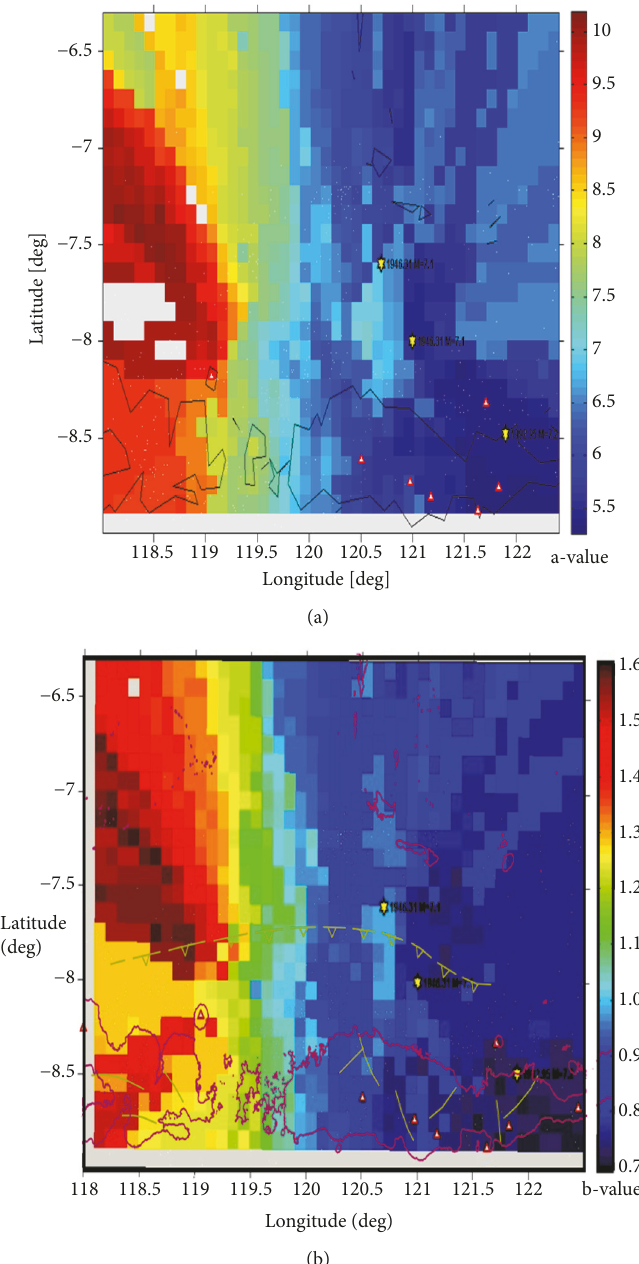
Figure 10: Spatial variation of seismicity of cluster 1 (Flores island, Labuan Bajo, and surrounding areas): (a) a-value and (b) b-value. 1996 and 2004. This is indicates the existence of a high level of stress on the rocks prior to the occurrence of the strong earthquakes